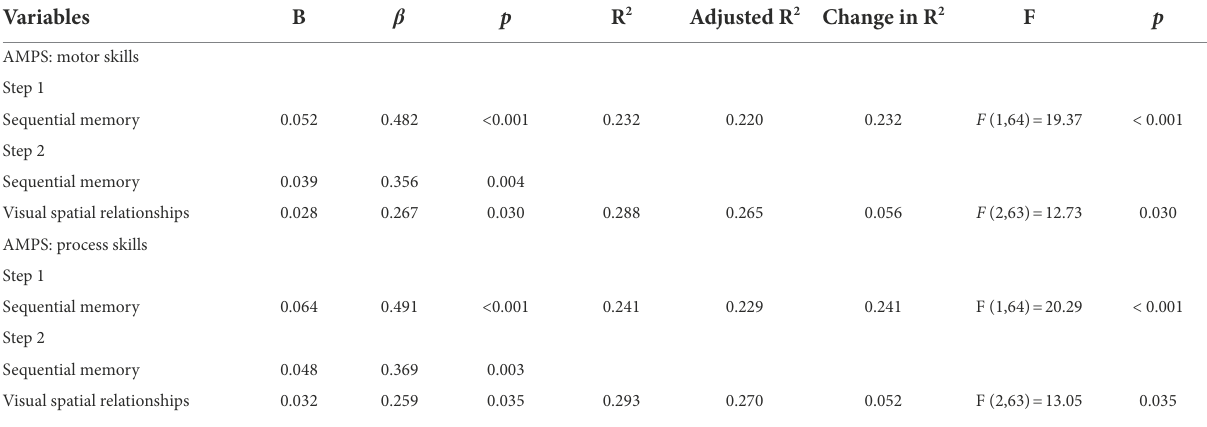
TABLE 2 Stepwise multiple regressions of motor-free visual perception on self-care performance.